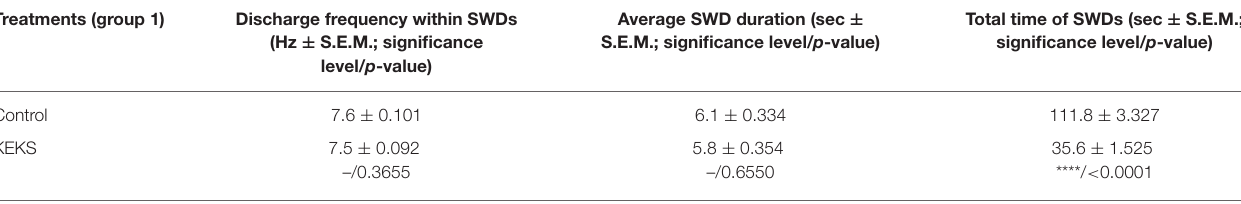
TABLE 2 | Effect of KEKS food (20% KEKS and 1% saccharin in standard rodent chow; group 1) on discharge frequency within SWDs, average SWD duration and total time of SWDs on 9th KEKS treatment day between 30 and 90min. Treatments (group 1)